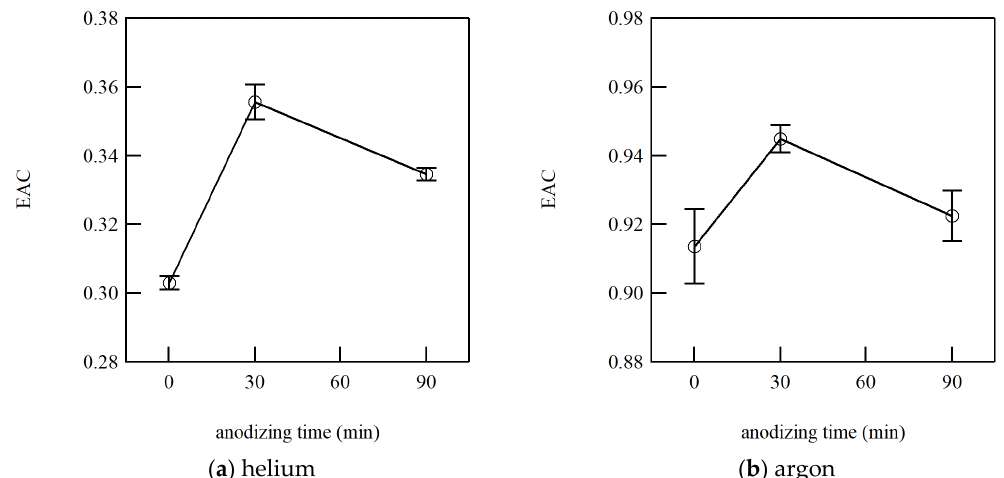
Figure 4. The measured EAC by Equation (5) as a function of the anodizing times of 0 min, 30 min and 90 min for ( a ) helium and ( b ) argon. Error bars show the standard error of 4 measurements for each condition.